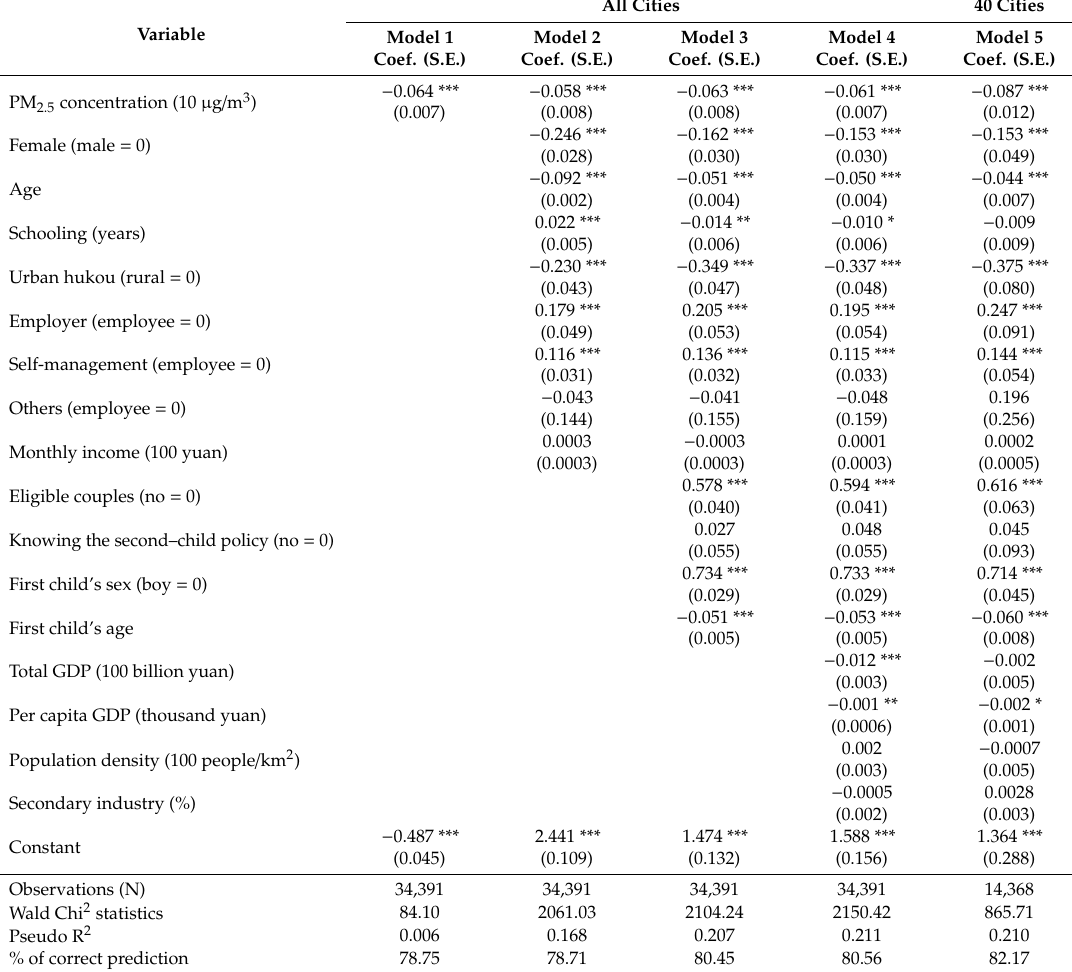
Table 2. Probit models: an estimate of second birth intentions of the floating population. All Cities 40 Cities Variable Model 1 Coef.